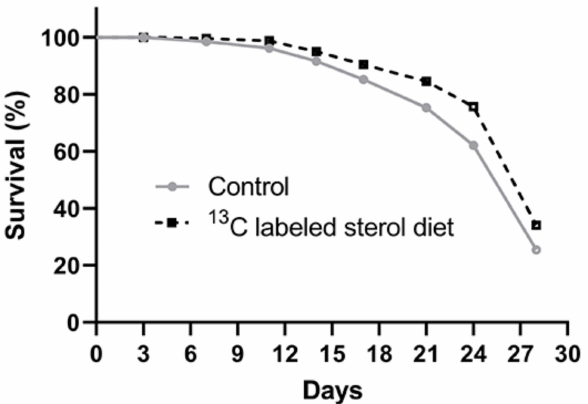
Figure 1. Kaplan-Meier survival curves for Control (honey bees fed diets with no sterol) and 13 C-labeled sterol diet (honey bees fed diet containing 0.25% 13 C-labeled 24-methylenecholesterol)